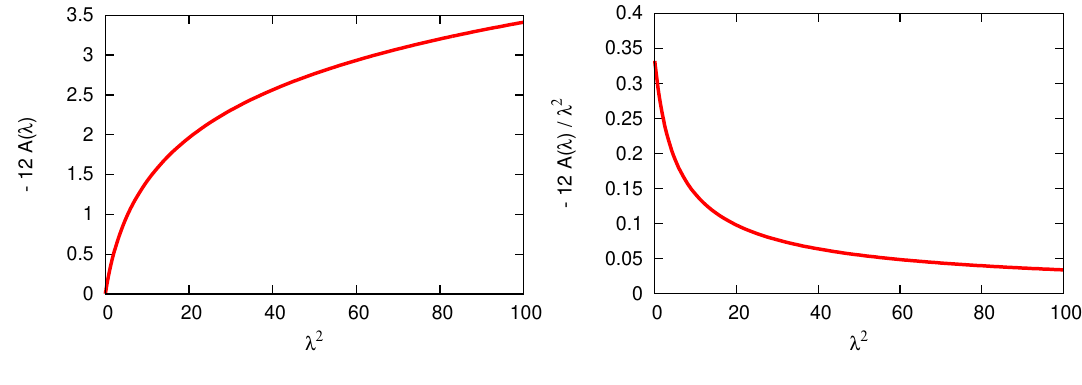
Figure 1 . The numerically evaluated A ( (cid:21) ) using (4.3).